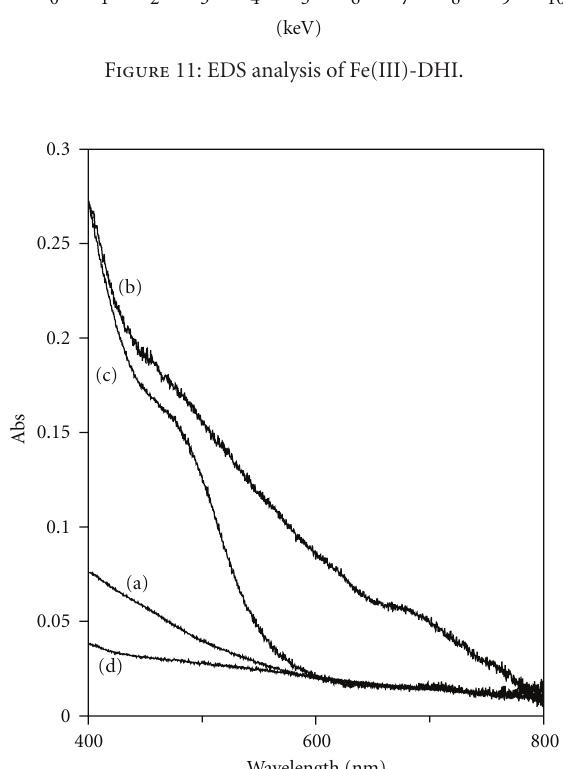
Figure 12: UV-Vis spectra of (a) poly-DHI film, (b) Cu-treated poly-DHI film, (c) Fe(III)-treated poly-DHI film, and (d) Fe(II)- treated poly-DHI film.